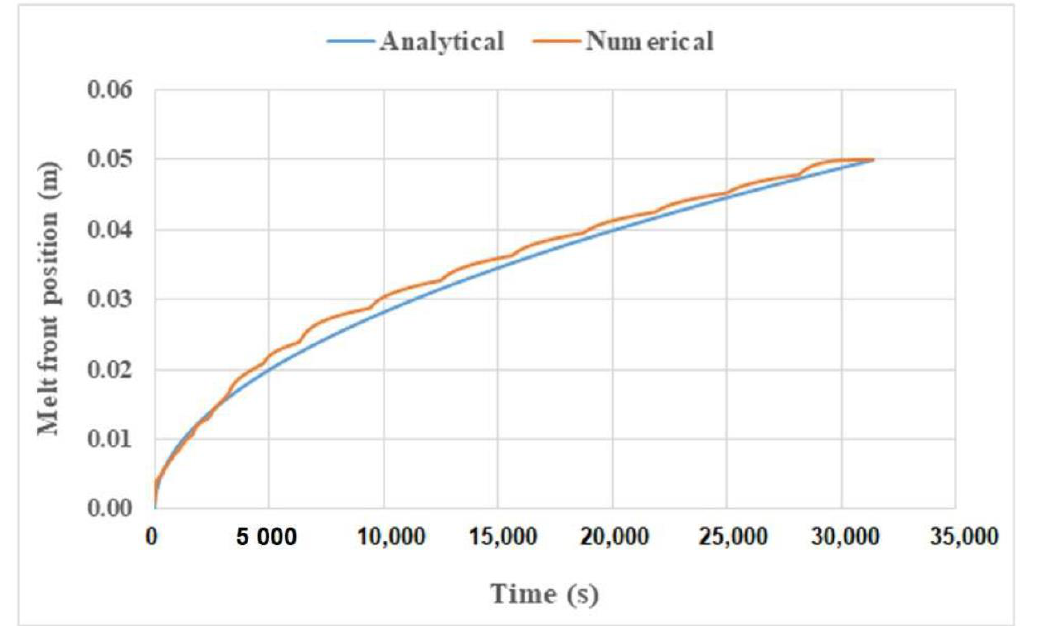
Figure 5. Analytical & Numerical solutions of the melting front position over time.